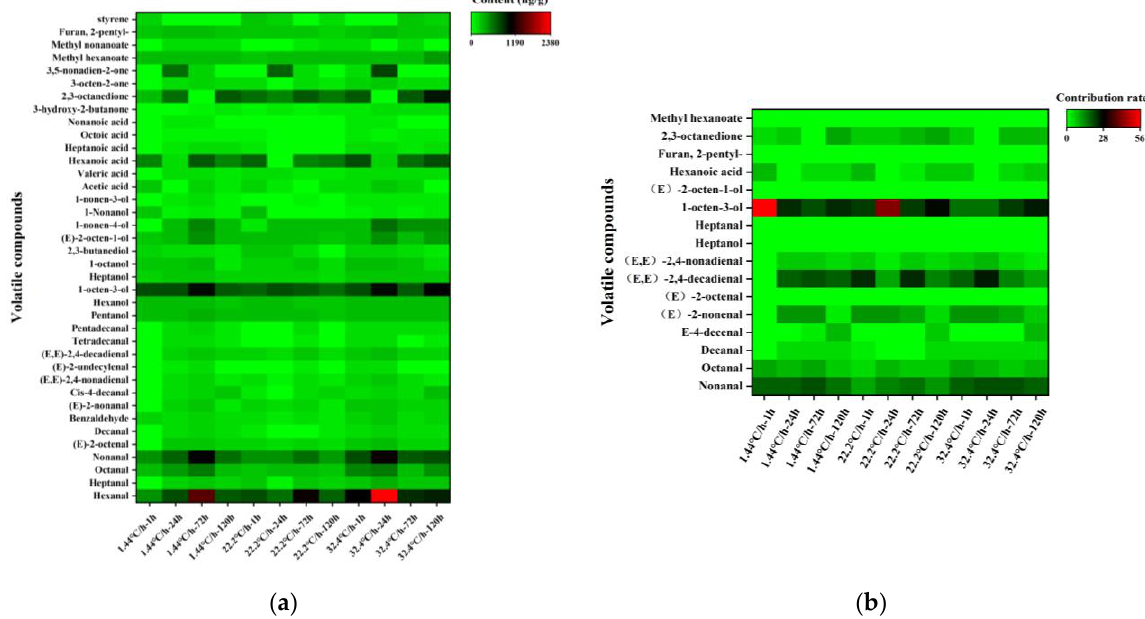
Figure 3. Contents and Contribution rates of volatile compounds in raw meat at different chilling rates during refrigeration. ( a ) Contents of volatile compounds. ( b ) Contribution rates of volatile compounds.